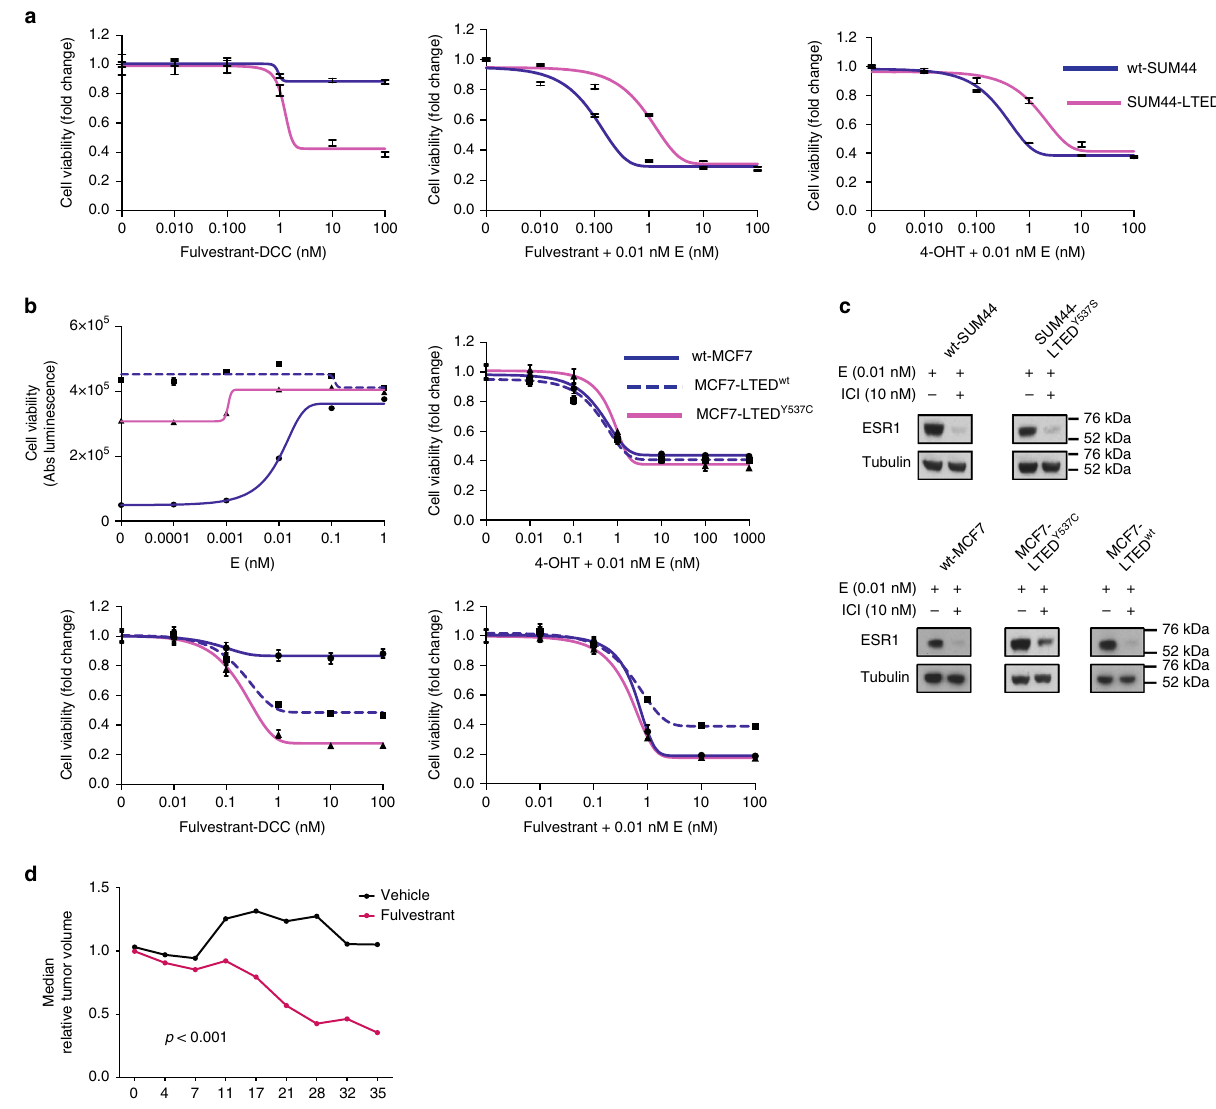
Fig. 6 Antiproliferative effect of endocrine therapy in ESR1 mutant and wt cell lines. a Proliferation assays assessing response of wt-SUM44 and SUM44- LTED and b wt-MCF7, MCF7-LTED wt , and MCF7-LTED Y537C to escalating concentration of fulvestrant ± E (estradiol) and 4-OHT plus E (estradiol). c Treatment of wt-SUM44, SUM44-LTED Y537S , wt-MCF7, MCF7-LTED Y537C , and MCF7-LTED wt with fulvestrant (10 nM) results in loss of ESR1 expression irrespective of mutation status ( n = 3 biological replicates consisting of n = 8 technical replicates). Data represent mean ± SEM. d Xenograft models of MCF7-LTED Y537C in response to vehicle or fulvestrant. Data represent median fold change in tumor volume. Signi fi cance was assessed using an unpaired t - test (Life Technologies) and sequenced on the Ion PGM System (Life Technologies). primer 5 ʹ - AAGTGGCTGCAGGGAGAGT-3 ʹ and reverse primer 5 ʹ - Reads were aligned by the PGM server with standard settings to the reference TGGTGCATGATGAGGGTAAA-3 ʹ . genome hg19, samtools v1.2 was used to calculate the on-target coverage. IonReporter (v4.4) was used for mutation calling (parameters: data quality Fluorescence in situ hybridization . FISH probes hybridizing at 6q25 (ESR1) and stringency = 12, downsample to coverage = 4000, SNP/InDel/MNP min cov each strand = 50, SNP/InDel/MNP min variant score = 15, SNP/InDel/MNP min chromosome-6 (CEN6) were purchased from Empire Genomics. Cell pellets were fi xed in 4% paraformaldehyde and paraf fi n-embedded. Five-micron sections were coverage = 250, hotspot min variant score = 6, hotspot min coverage = 150). All mutations called were manually reviewed in Integrative Genomics Viewer (IGV) subjected to the SwiftFISH rapid hybridization protocol (Empire Genomics), and included in the analysis if they had a VAF ≥ 1%. according to the manufacturer ’ s instructions. Sections were mounted in DAPI- containing Vectashield (Vector). FISH probes signals were analyzed using fl uor- escent microscope (Leica). ddPCR . ddPCR assays for the ESR1 mutations Y537S and Y537C using Taqman probes were used as previously described 10 . Very-low-frequency mutations were only considered to be present if two or more FAM-positive droplets were detected in the total of the wt sample. Cycle sequencing for validation . ESR1 mutations were validated by cycle (GSE100075). K-means clustering was performed using the k-means function in sequencing by euro fi ns genomics (Euro fi ns). DNA was ampli fi ed using forward the stats package in R. The number of clusters used was determined by the number NATURE COMMUNICATIONS | 8: 1865 | DOI: 10.1038/s41467-017-01864-y |